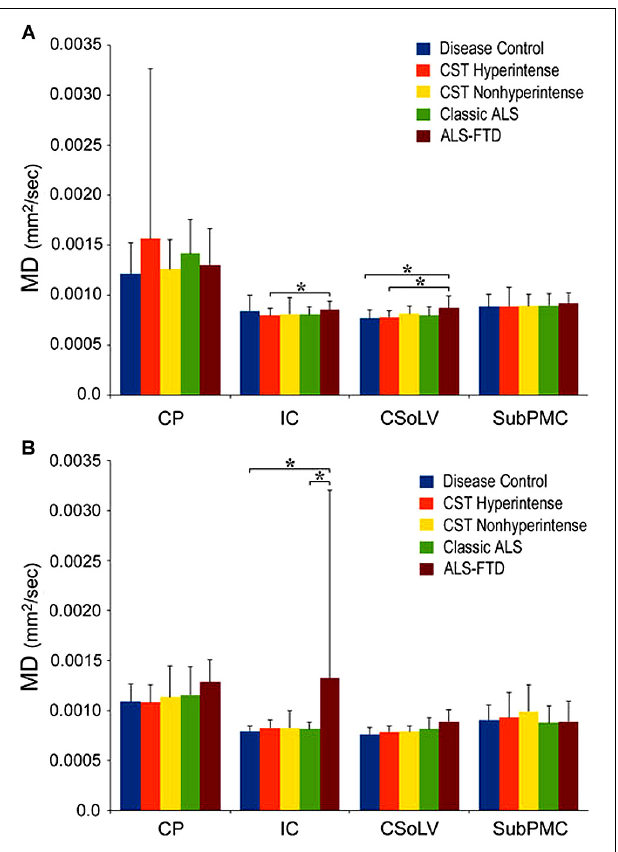
FIGURE 3 | AD values at four CST levels in left (A) and right (B) hemispheres of ALS patients compared to controls showing significant differences as ∗ P < 0.05. CP, cerebral peduncle; IC, posterior limb of internal capsule; CSoLV, centrum semiovale at top of lateral ventricle; subPMC, subjacent to primary motor cortex. Reproduced with permission from Springer Nature.